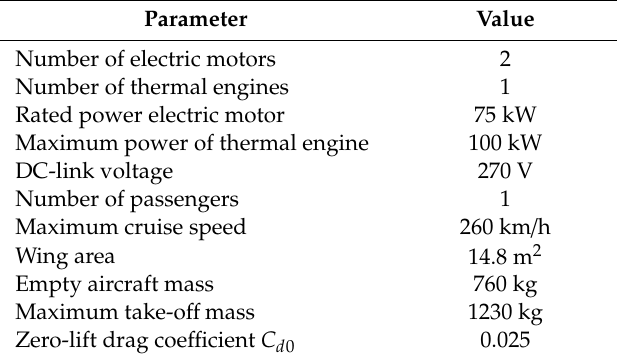
Table 1. Main parameters of the aircraft selected as a case study.